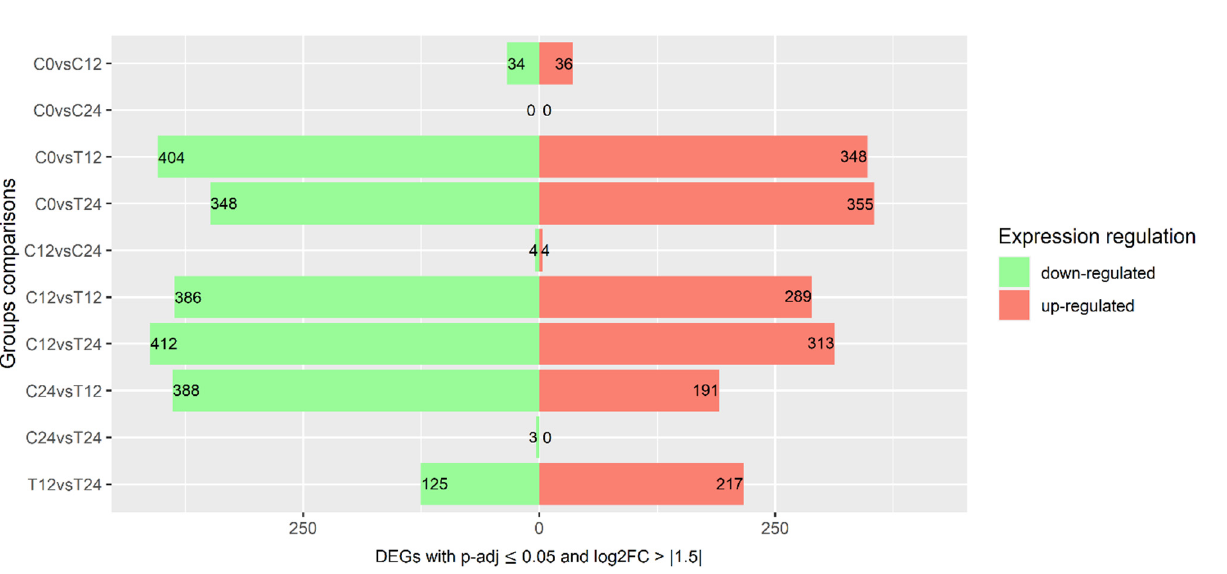
Figure 2. Differentially expressed genes. Total number of differentially expressed genes with p -adj ≤ 0.05 and log2FC > |1.5| between pairwise comparisons. Green bars represent downregulated genes, while red represent upregulated genes. Samples are identified as C (control) or T (treated) followed by the time point.